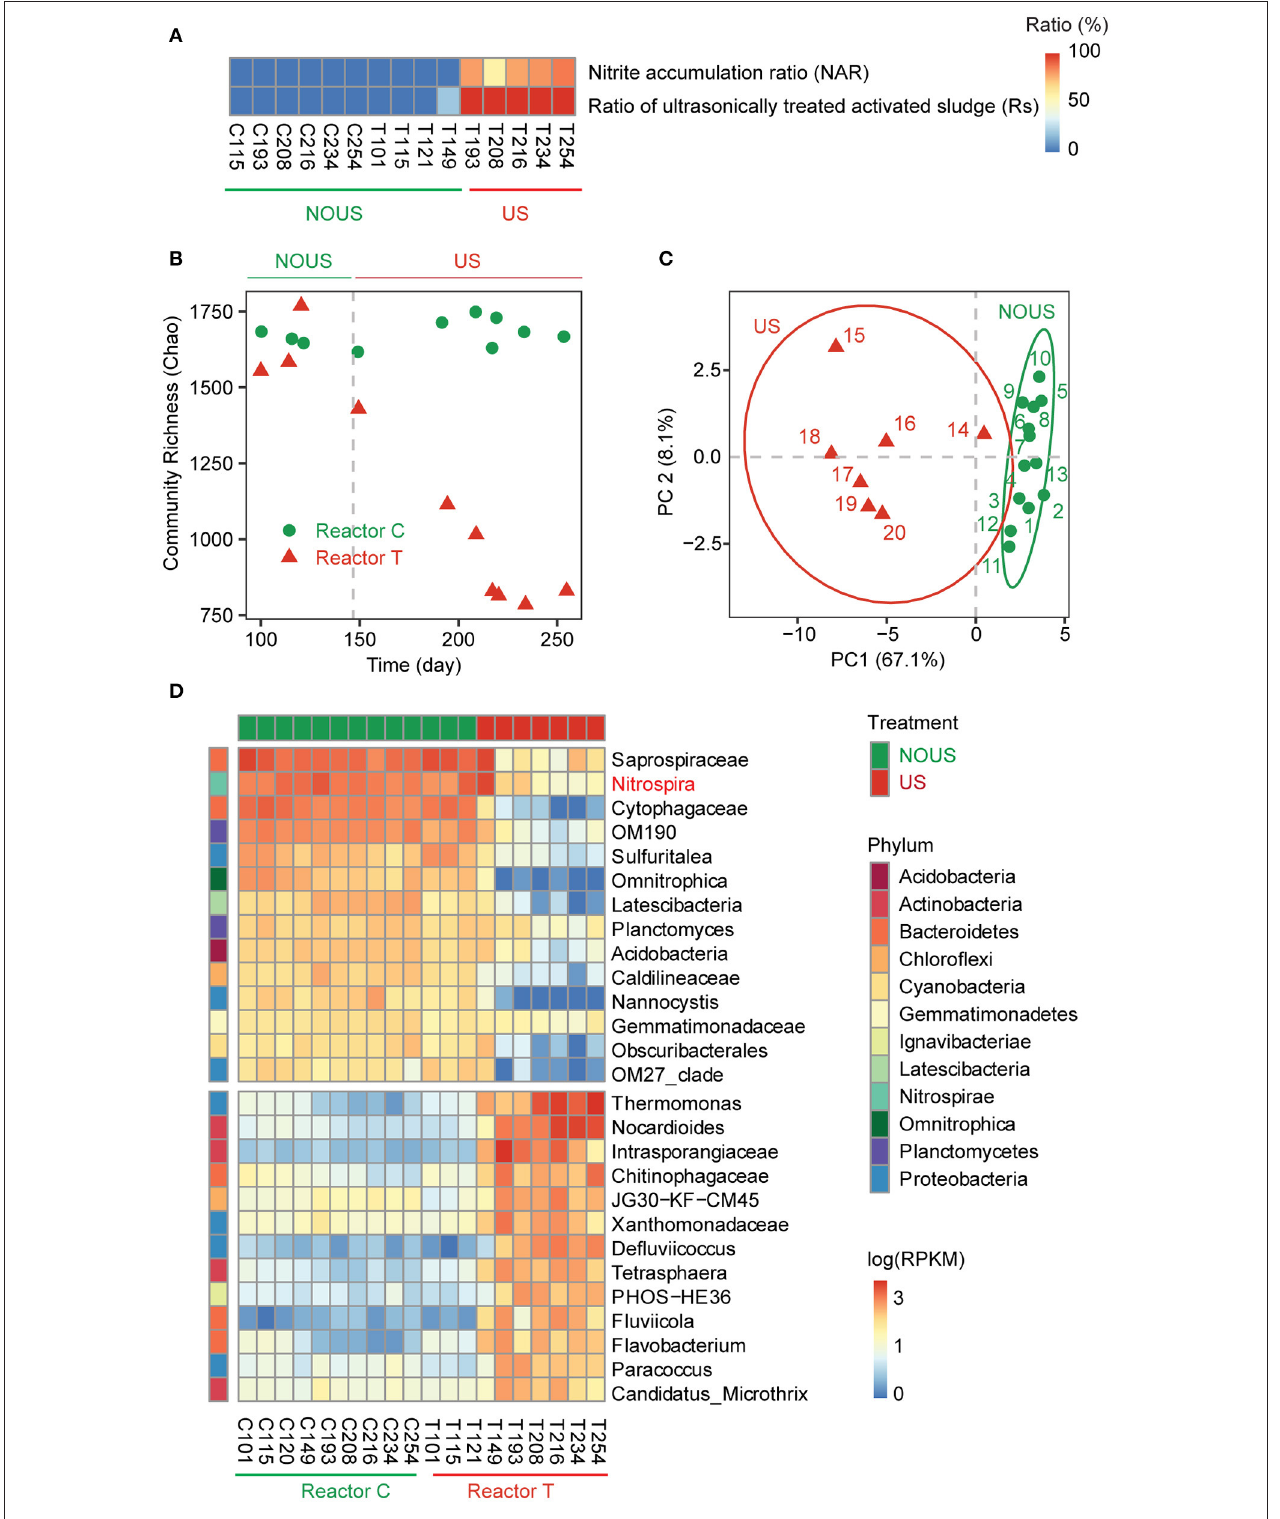
FIGURE 1 | Phylogenetic profile of the microbial community. (A) Performance of reactor. (B) Variation of community diversity with reactor operation time using Chao index. (C) Principle component analysis (PCA) of the microbial community. (D) Heatmap of the genera contributing to the principal components of the microbial community and their abundance in each sample. The abundance of microbes was scaled to log10 of reads per kilobase per million mapped reads (RPKM). Samples were clustered into ultrasonic treatment (US) and without ultrasonic treatment (NOUS) groups by using PCA and ANOSIM. The phylum level of each genus was labeled on the left of the